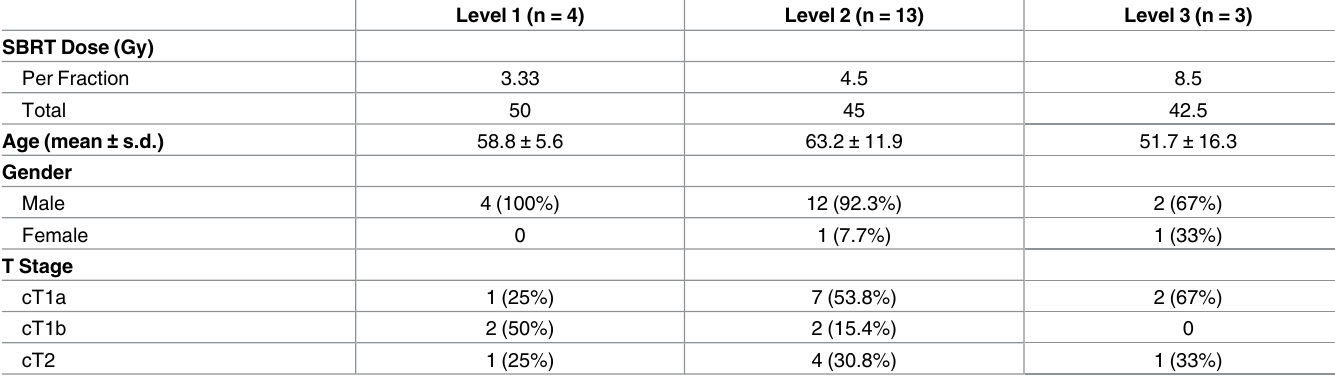
Table 1. Patient